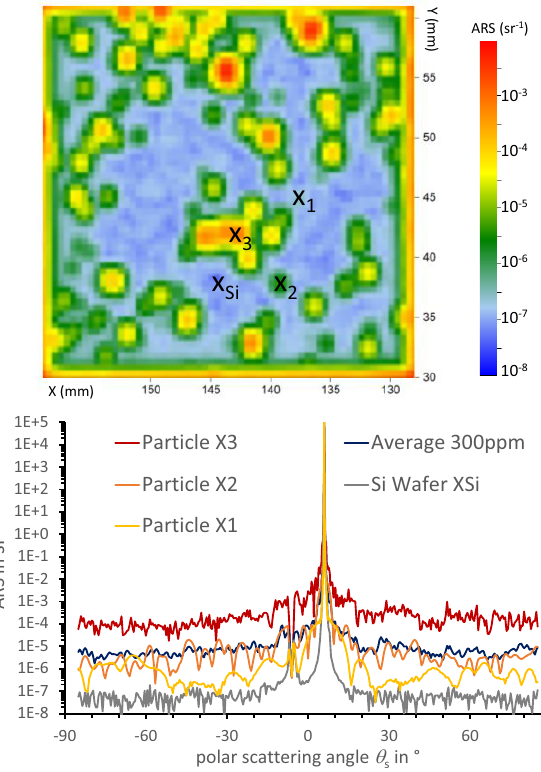
polar scattering angle (cid:2) in s Fig. 1. Light scattering from contamination. Top: scattering mapping obtained by laterally scanning a supersmooth Si- wafer at fixed scattering angle direction; bottom: ARS of this silicon wafer at the indicated particle sites.